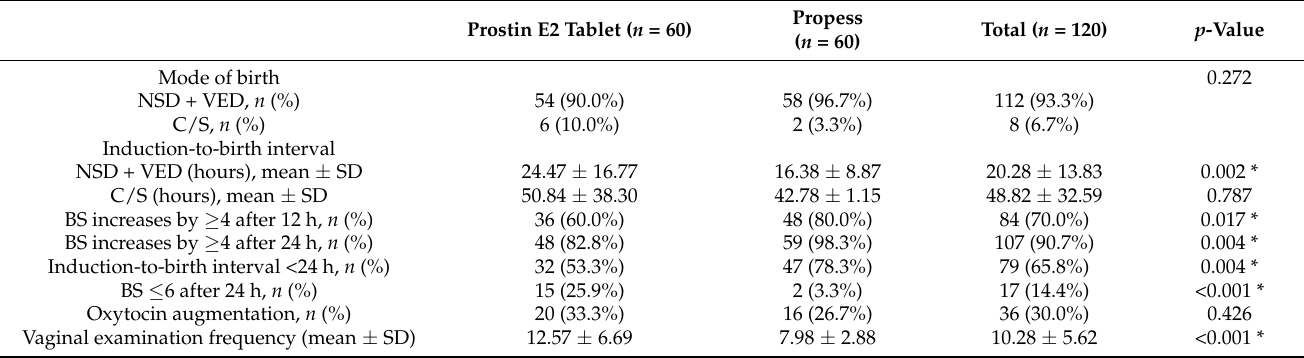
Table 2. Summary of the efficacy of Propess and Prostin